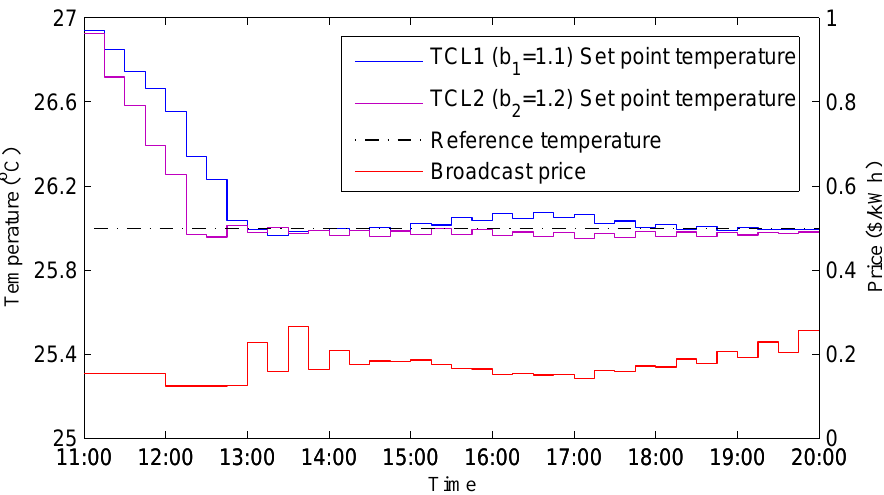
Figure 10. TCLs with different priority factor b